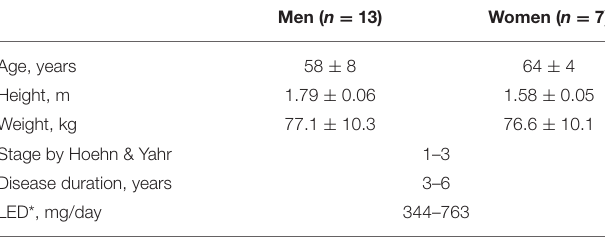
TABLE 1 | The anthropologic and clinical data of the subjects with PD. Men ( n =